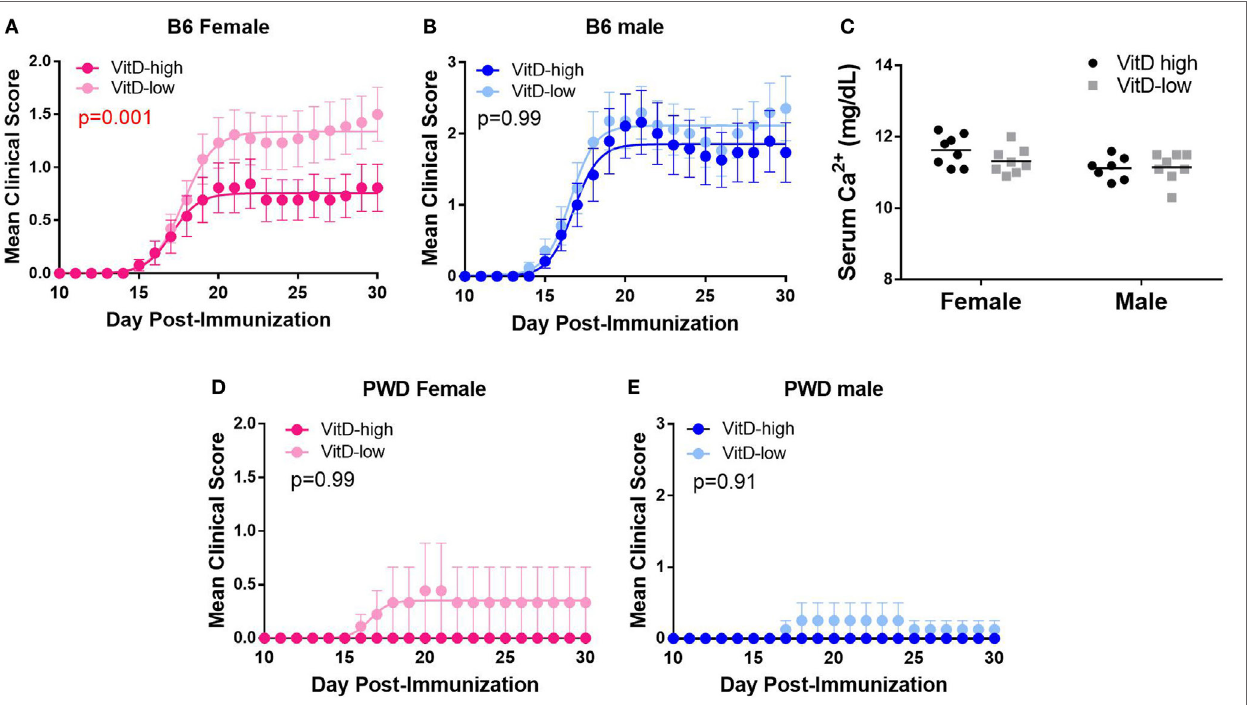
FigUre 2 | Strain- and sex-specific suppression of EAE by vitamin D3 (VitD). B6 (a–c) and PWD (D,e) mice were maintained on VitD-high and VitD-low diets as in Figure 1 , followed by EAE induction after 5 weeks post-dietary intervention. Mice were maintained on the respective diets until the end of the experiment. (c) B6 serum Ca 2 + levels were measured for the indicated groups, and the significance of the observed differences assessed by two-way ANOVA, followed by Holm–Sidak’s post hoc comparisons. The significance of the observed differences in the severity of the clinical disease course was assessed as described in Section “Materials and Methods.” p -Values for the effect of diet on overall disease course (representing the interaction term for treatment × time, repeated measures two-way ANOVA) are shown. The numbers of animals for each group are provided in Table S1 in Supplementary